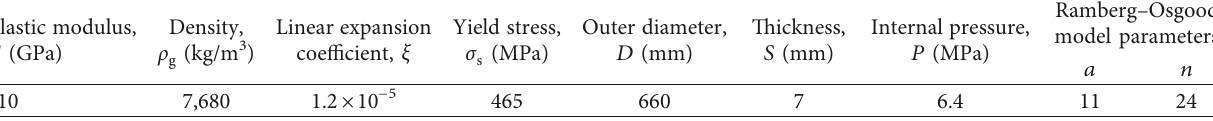
Table 3: Physical mechanical parameters of the buried natural gas pipeline.